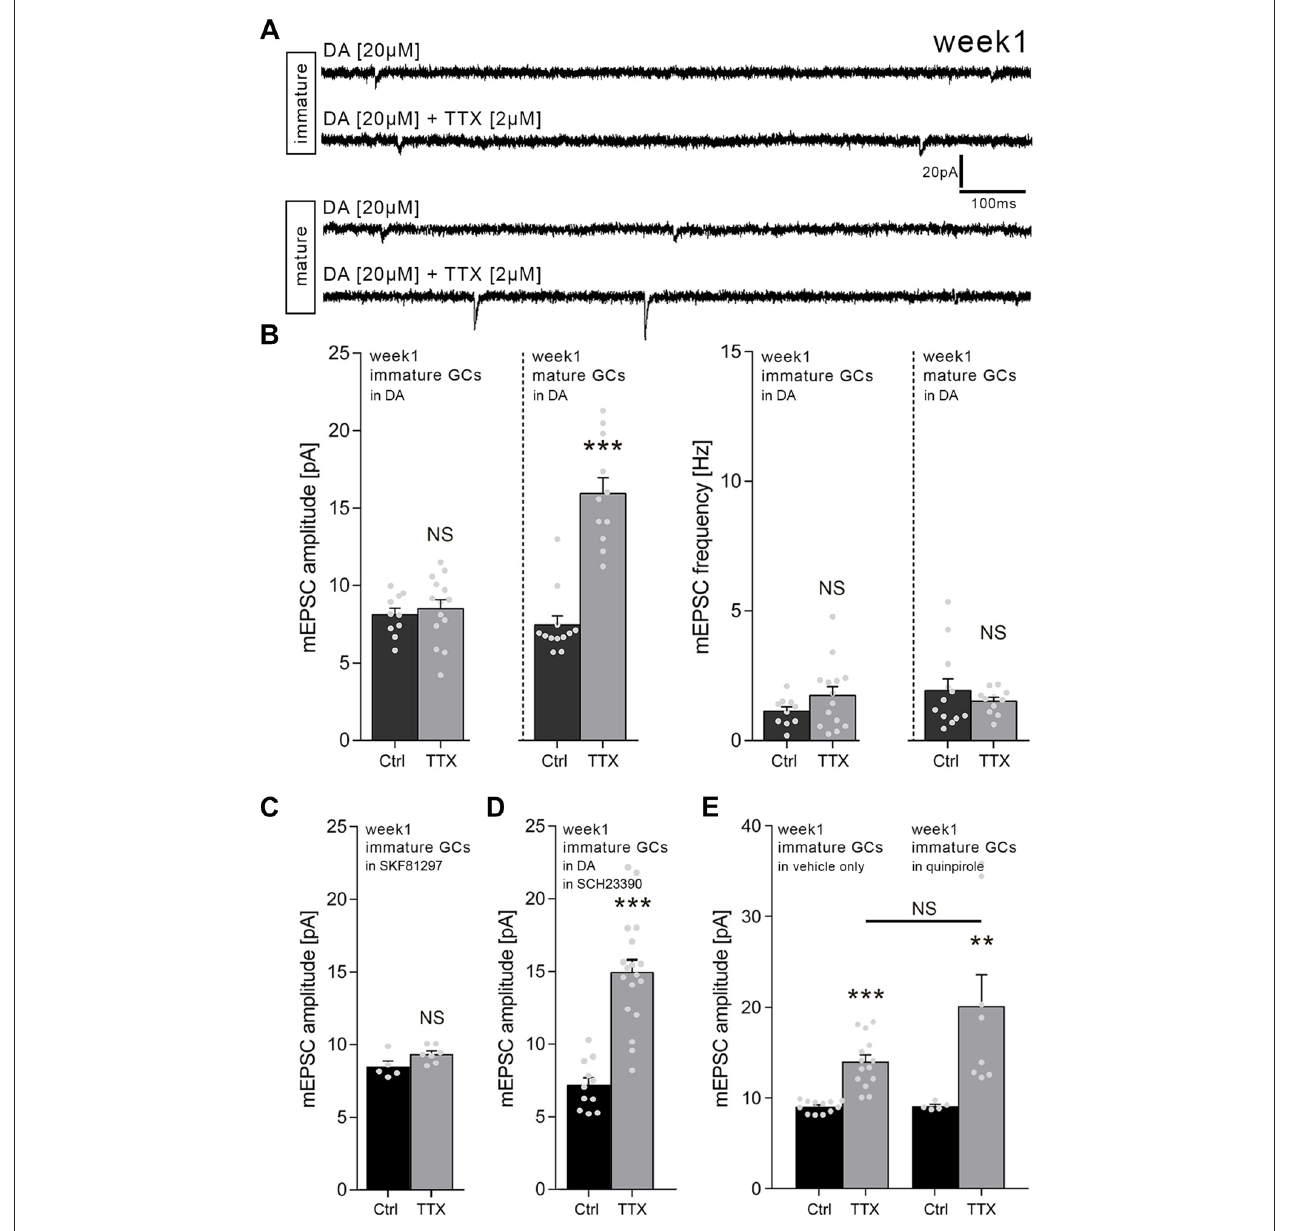
FIGURE 2 | Dopamine (DA) prevents homeostatic synaptic plasticity of immature but not mature GCs in 1-week-old slice cultures. (A) Sample traces of AMPA receptor-mediated mEPSCs recorded from immature and mature GCs under various conditions (TTX, tetrodotoxin; DA, dopamine). (B) Group data of mEPSC recordings (amplitudes and frequencies). DA blocks TTX-induced excitatory synaptic scaling in immature but not mature GCs of 1-week-old slice cultures (immature: n control = 10 cells, n TTX = 14 cells; mature: n control = 12 cells, n TTX = 11 cells; Mann-Whitney test; U-value = 2). (C) The D 1 -like agonist SKF81297 (20 µ M; 3 days) blocks TTX-induced excitatory synaptic scaling in immature GCs of 1-week-old slice cultures ( n control = 5 cells, n TTX = 7 cells; Mann-Whitney test). (D) In presence of the D 1 / 5 receptor antagonist SCH23390 (40 µ M; 3 days) DA does not block TTX-induced excitatory synaptic scaling in immature GCs of 1-week-old slice cultures ( n